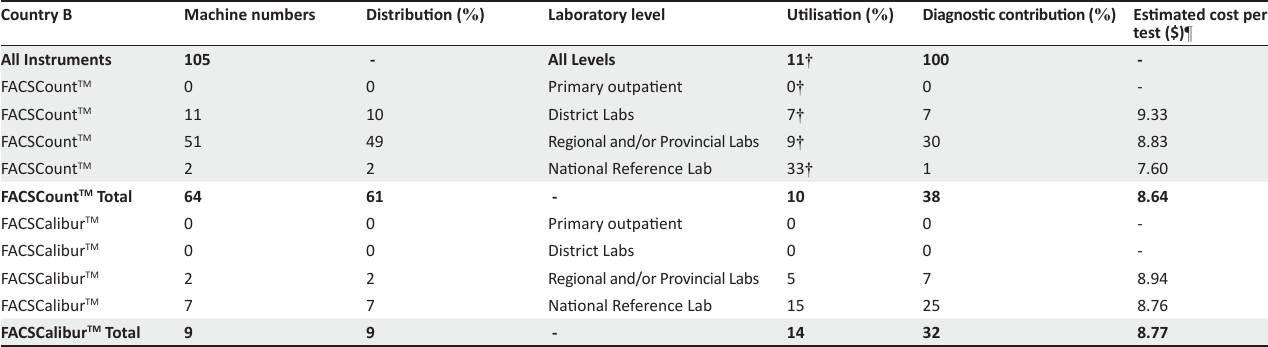
TABLE 4: Country B CD4 Testing Equipment Utilisation. Country